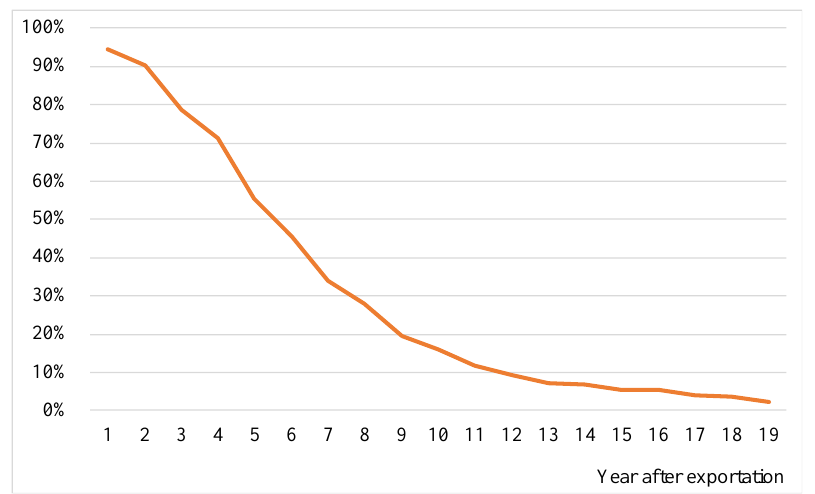
Figure 3. The remaining rate of secondhand hybrid vehicles (HVs) exported to Mongolia. Source: Figure made by the author based on Automobile Inspection & Registration Information Association’s data [20].